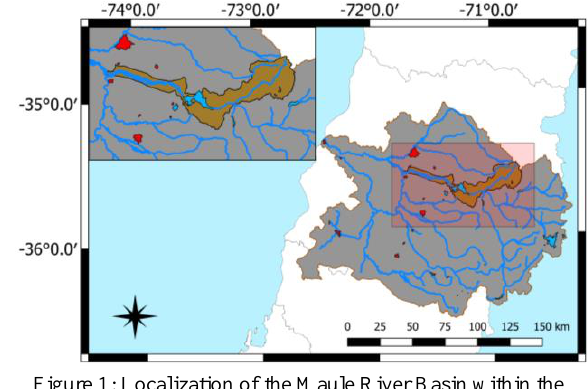
Figure 1: Localization of the Maule River Basin within the Middle Maule sub-basin. Red areas are cities.